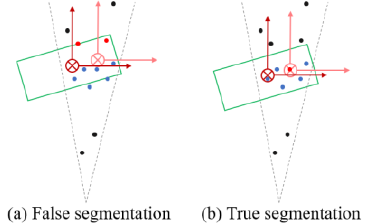
Figure 2. Influence of instance segmentation. Artificial points are shown to illustrate, the red point is false segmentation, blue point is true segmentation point. (a) False segmentation and predict 3D bounding box. (b) True segmentation and predict 3D bounding